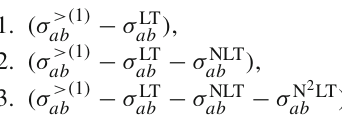
, for H boson production, in the qg → Hq (left pane) and in the (cid:9) (cid:10) T 2 are displayed on the top of the figure / m q cut H T